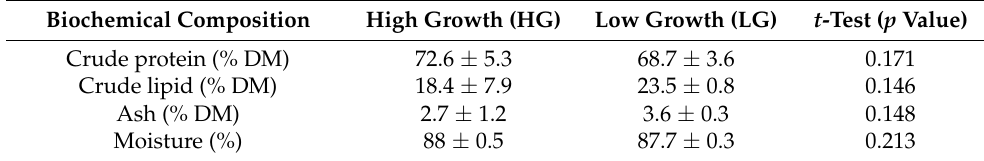
Table 7. Biochemical composition of eggs obtained from the gilthead seabream broodstock selected for high (HG) or low (LG) growth before feeding broodstock experimental diets (HG, n = 3; LG, n = 3). Biochemical Composition